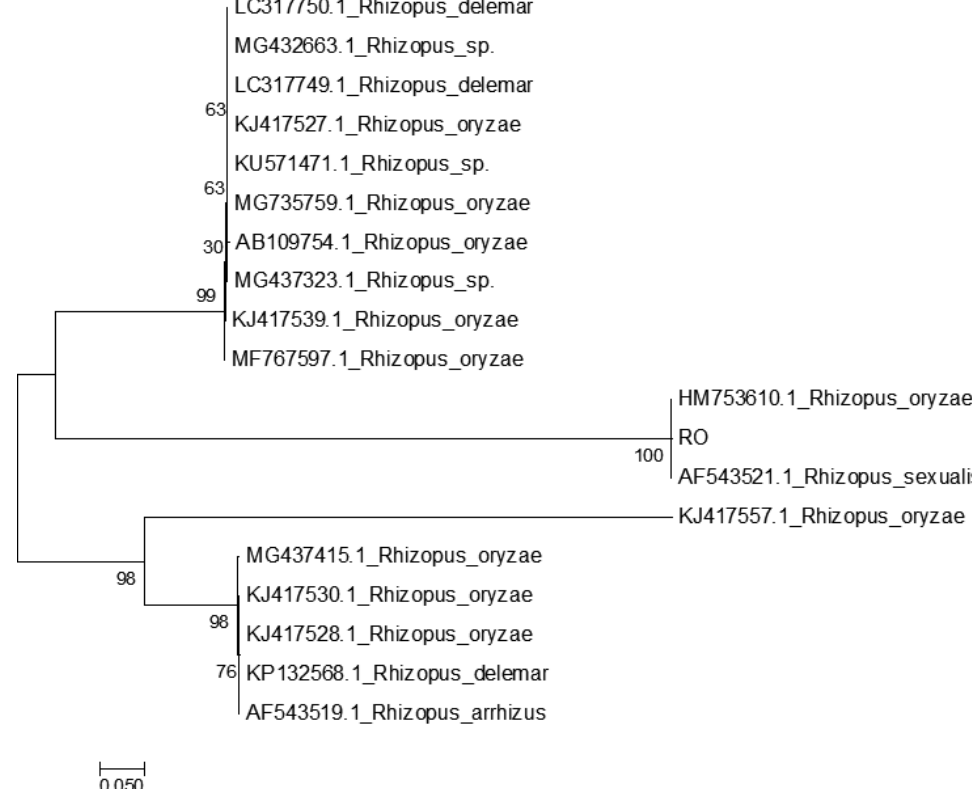
Figure 2. Phylogenetic analysis of a Rhizopus oryzae isolate from pak choy, with 18 related sequences from GenBank. Resulting from 1,000 replicates, bootstrap values are shown at the branch